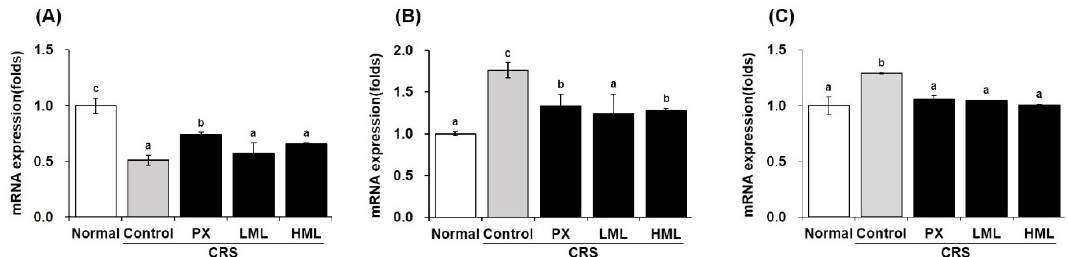
Figure 5. Effects of the ML extracts on mRNA expression of apoptosis-related genes in brain tissue. Apoptosis-related gene were detected by real-time PCR. (A) Bcl-2, (B) Bax, (C) Caspase-3. Data represent means ± SEM ( n = 5). Different letters (a–c) above the bars indicate significant differences at p < 0.05. CRS—chronic restraint stress; PX—paroxetine; LML—low-concentration mustard leaf; HML—high-concentration mustard leaf.